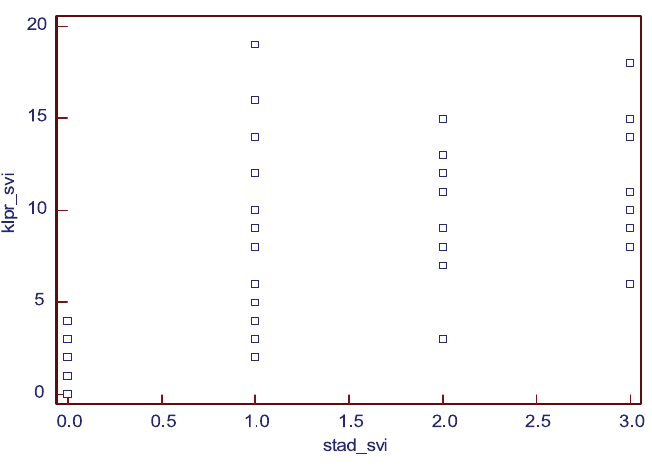
FIGURe 2. correlations between scores of clinical symptoms and stages of oSd Table 5. assessment of pain in patients with osgood-Schlatter